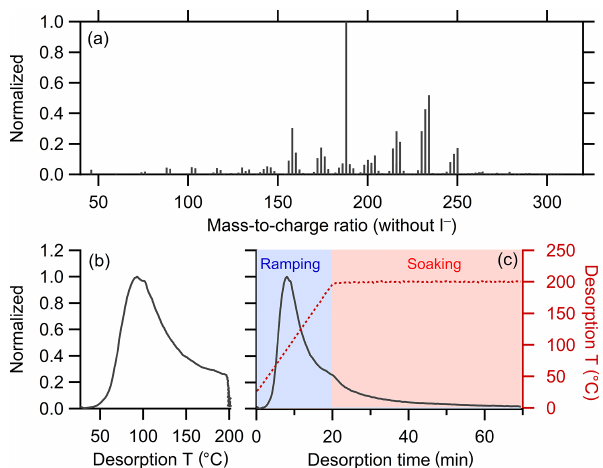
Figure 6. Same as Fig. 3, but for (cid:49) -3-carene + OH SOA. (a) SOA mass spectrum measured by FIGAERO-CIMS. The mass ex- cludes iodine. The normalized thermogram of the bulk SOA ver- sus (b) temperature and (c) time. In (c) the light blue shaded area denotes the ramping period and the pink shaded area the soaking